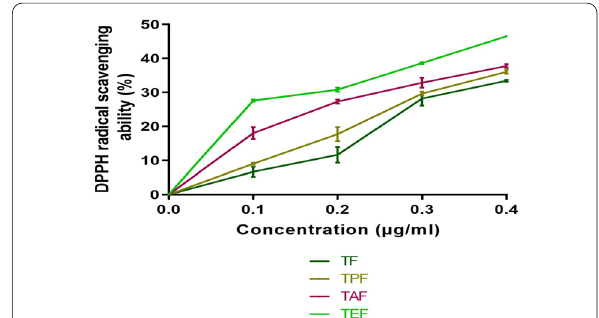
Fig. 4 DPPH radical scavenging ability of native and modified tacca flour. TF: Native tacca flour, TPF: tacca physical flour, TAF: tacca acetylated flour, TEF: tacca enzymatic starch